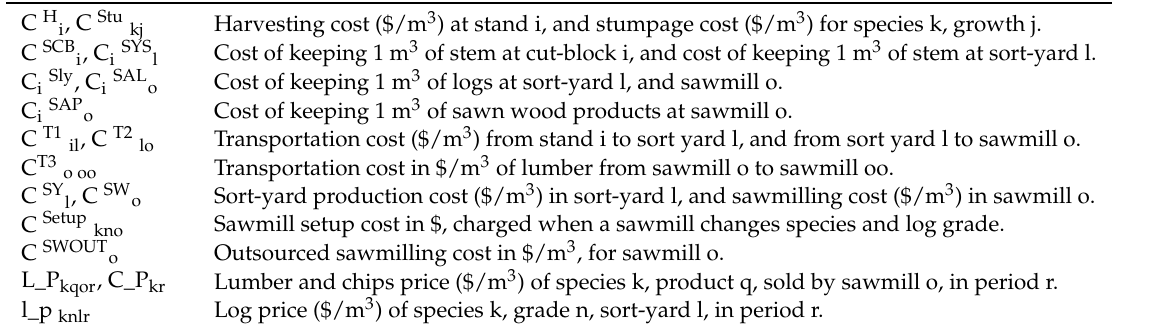
Table A2. Operational and inventory costs.